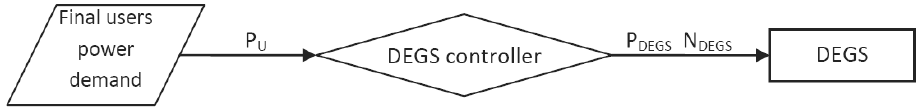
Figure 2. Energy system base scenario .